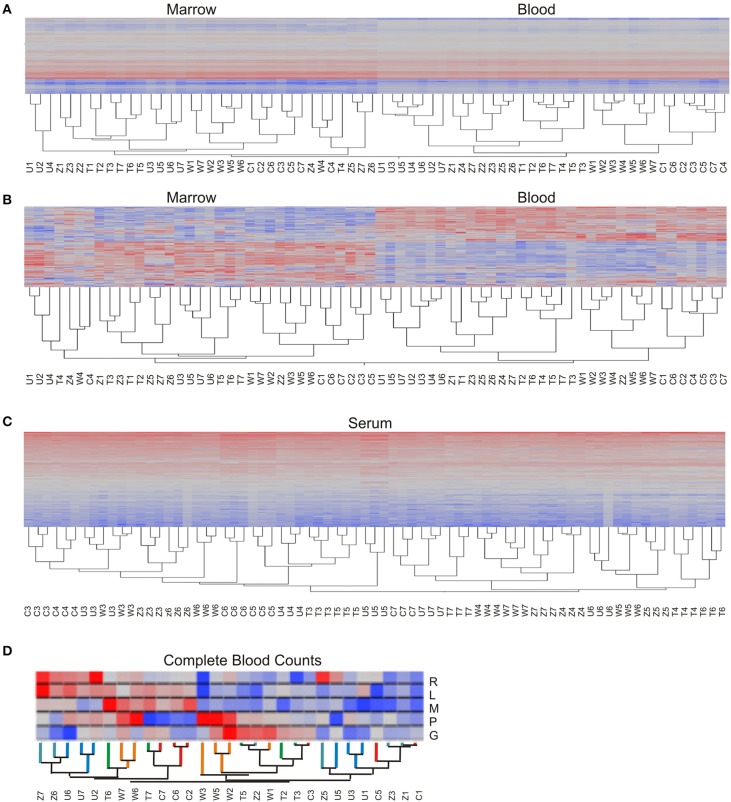
Two-way hierarchical clustering. Each heat map shows the abundance of each transcript or metabolite (rows) in each sample (column) with red indicating high expression, blue low, gray intermediate. (A) Transcriptome, based on absolute log-2 intensity estimates, and (B) based on standardized log-2 intensities, in both cases combining both BM and PB in the same clustering. (C) Plasma metabolome, where each column is a technical replicate, showing almost perfect alignment of each of the three replicates of each sample. (D) Complete blood counts are clustered with the branches of the dendrogram colored according to the identity of the animal, and cell types ordered as Red Blood Cells, Lymphocytes, Monocytes, Platelets, and Granulocytes (R, L, M, P, G respectively). Each macaque is abbreviated as C, T, U, W, or Z for RCs13, RTi13, RUn113, RWr13, or RZE13 respectively, and numbers refer to timepoints.